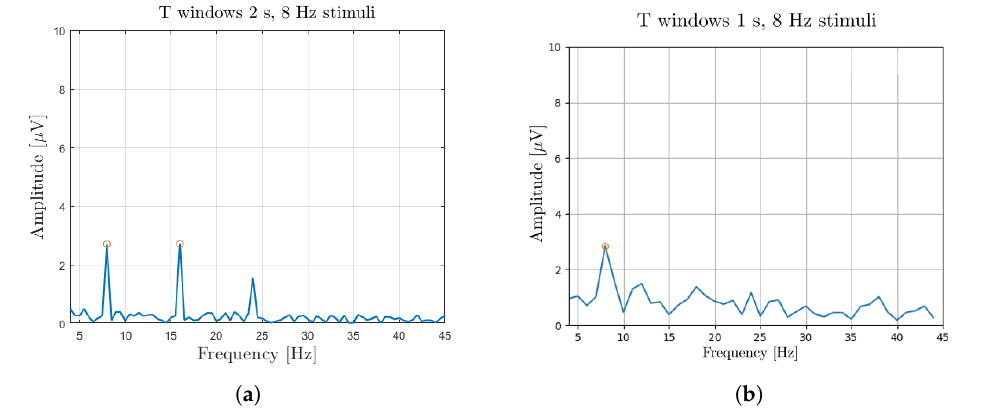
Figure 6. FFT analysis of SSVEP response for a 8 Hz visual stimulus. ( a ) Time window 2 s. ( b ) Time window 1 s.